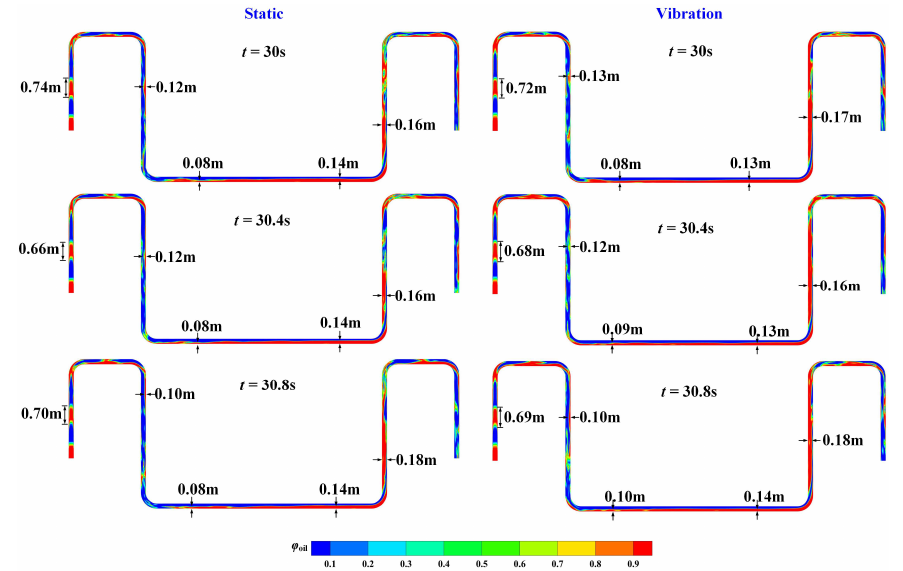
Figure 12. Comparison of the flow regimes in the jumper between the static and vibration conditions for case 1, where φ oil is the volume fraction of oil and t is the flow time.